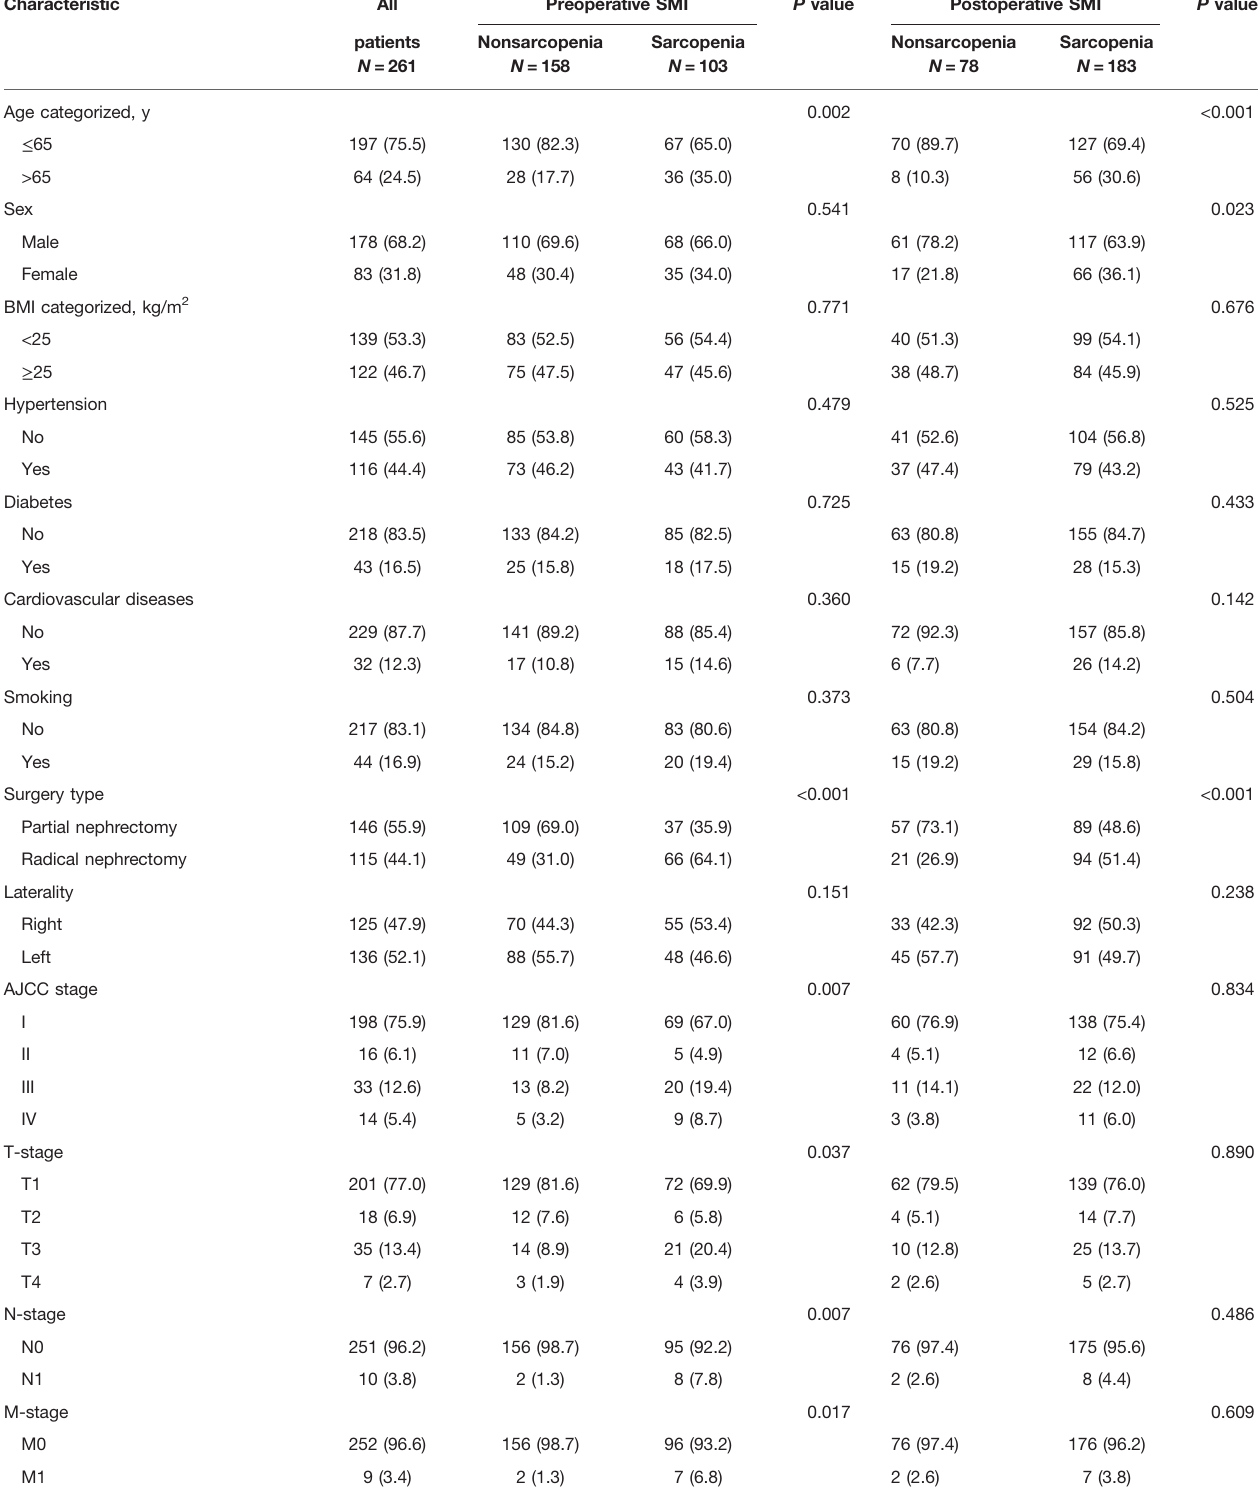
TABLE 1 | Clinical characteristics of the patients according to pre- and postoperative